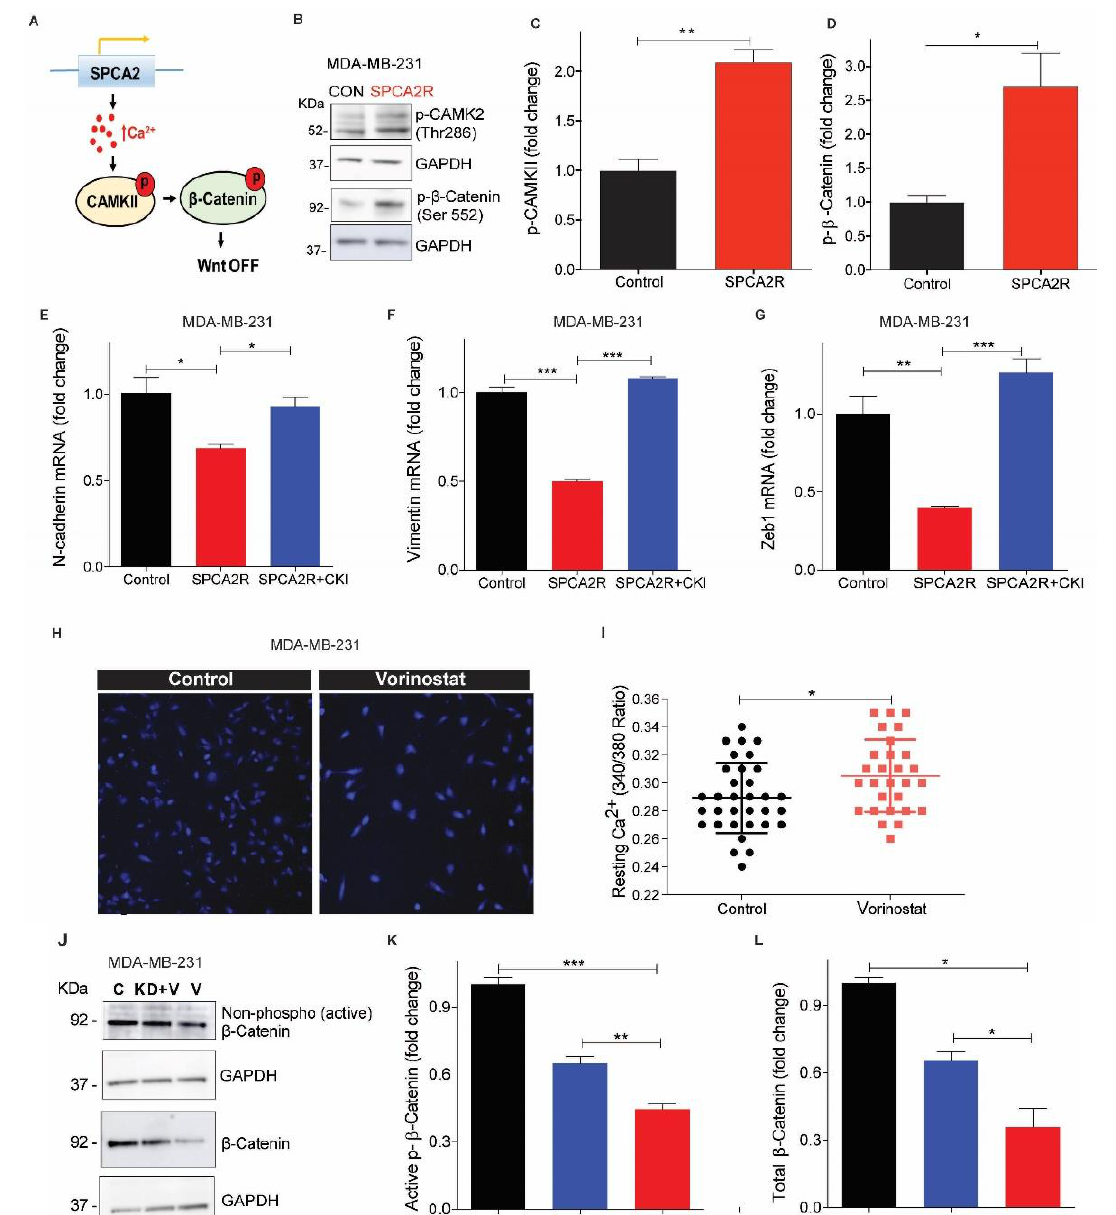
Figure 6. SPCA2 activates downstream Wnt/Ca 2+ signaling. ( A ) Schematic of downstream activation of Wnt/Ca 2+ signaling by SPCA2. Store-independent Ca 2+ entry activated by SPCA2 increases cytoplasmic Ca 2+ , activating CAMKII and inactivating -catenin by phosphorylation, turning Wnt pathway OFF. ( B ) Representative Western blot of p-CAMKII and p-β-catenin in MDA-MD-231 transfected with vector control or SPCA2R; GAPDH was used as a loading control. ( C , D ) Quantitation of Western blots ( n = 3) by densitometry. ( E – G ) Ectopic expression of SPCA2 (SPCA2R) in MDA-MB-231 decreased the mesenchymal gene markers, N-cadherin, vimentin, and Zeb1, which were significantly reversed by addition of CAM Kinase II inhibitor (KN 93 phosphate, 20 µM, 24 h). n = 3. ( H ) Representative live cell Ca 2+ imaging (2.5× magnification) in calcium-free conditions using Fura2-AM in MDA-MB-231 treated with vehicle (control) or vorinostat (2.5 µM for 24 h). ( I ) Fluorescence emission ratio of excitation at 340/380 nm showing increase in average resting Ca 2+ in the presence of vorinostat ( n = 28 cells) compared to vehicle control ( n = 33 cells). ( J ) Representative Western blot of non-phosphorylated (active) and total β-catenin in MDA-MD-231 control (scrambled shRNA) and SPCA2 KD, treated with vorinostat as indicated; GAPDH was used as a loading control. ( K , L ) Quantitation of Western blots by densitometry ( n = 3). SPCA2 KD significantly reversed the decrease in active and total levels of β-catenin by vorinostat. Student t -test, *** p < 0.001, ** p < 0.01, * p < 0.05.